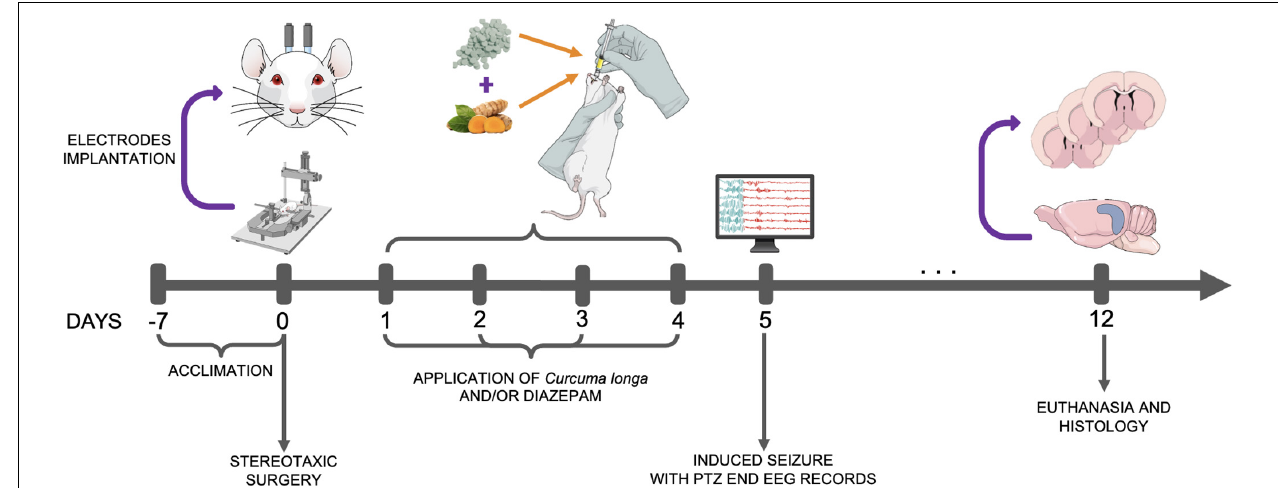
FIGURE 1 | Experimental design. PTZ, pentylenetetrazol; EEG,